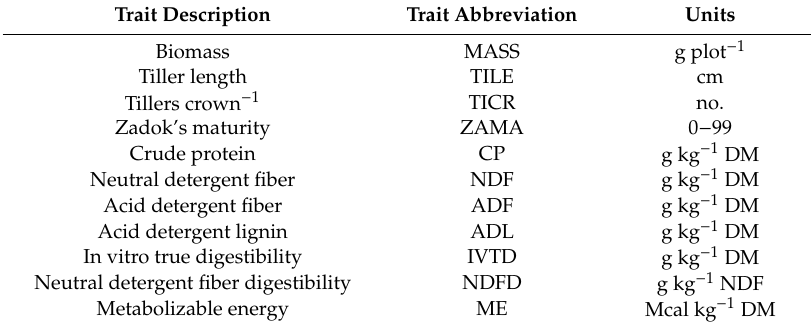
Table 1. Trait description, abbreviation, and units of traits measured on the M26 × M35 intermediate wheatgrass mapping population evaluated over two years at Logan, UT, USA in three clonally replicated competition